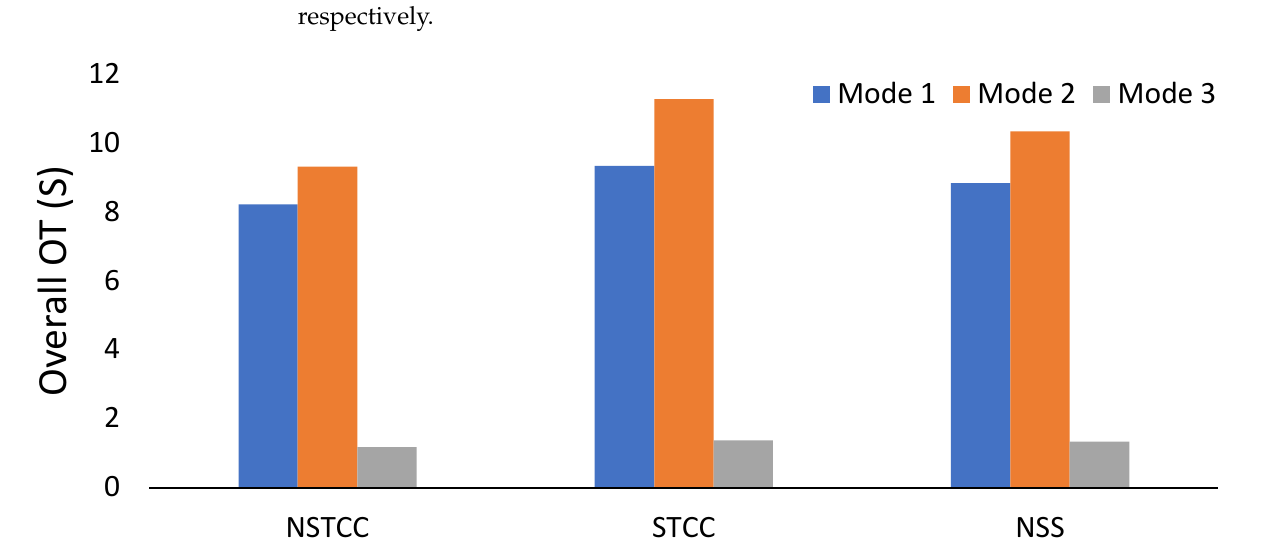
Figure 9. The overall OT in Modes 1, 2, and 3.